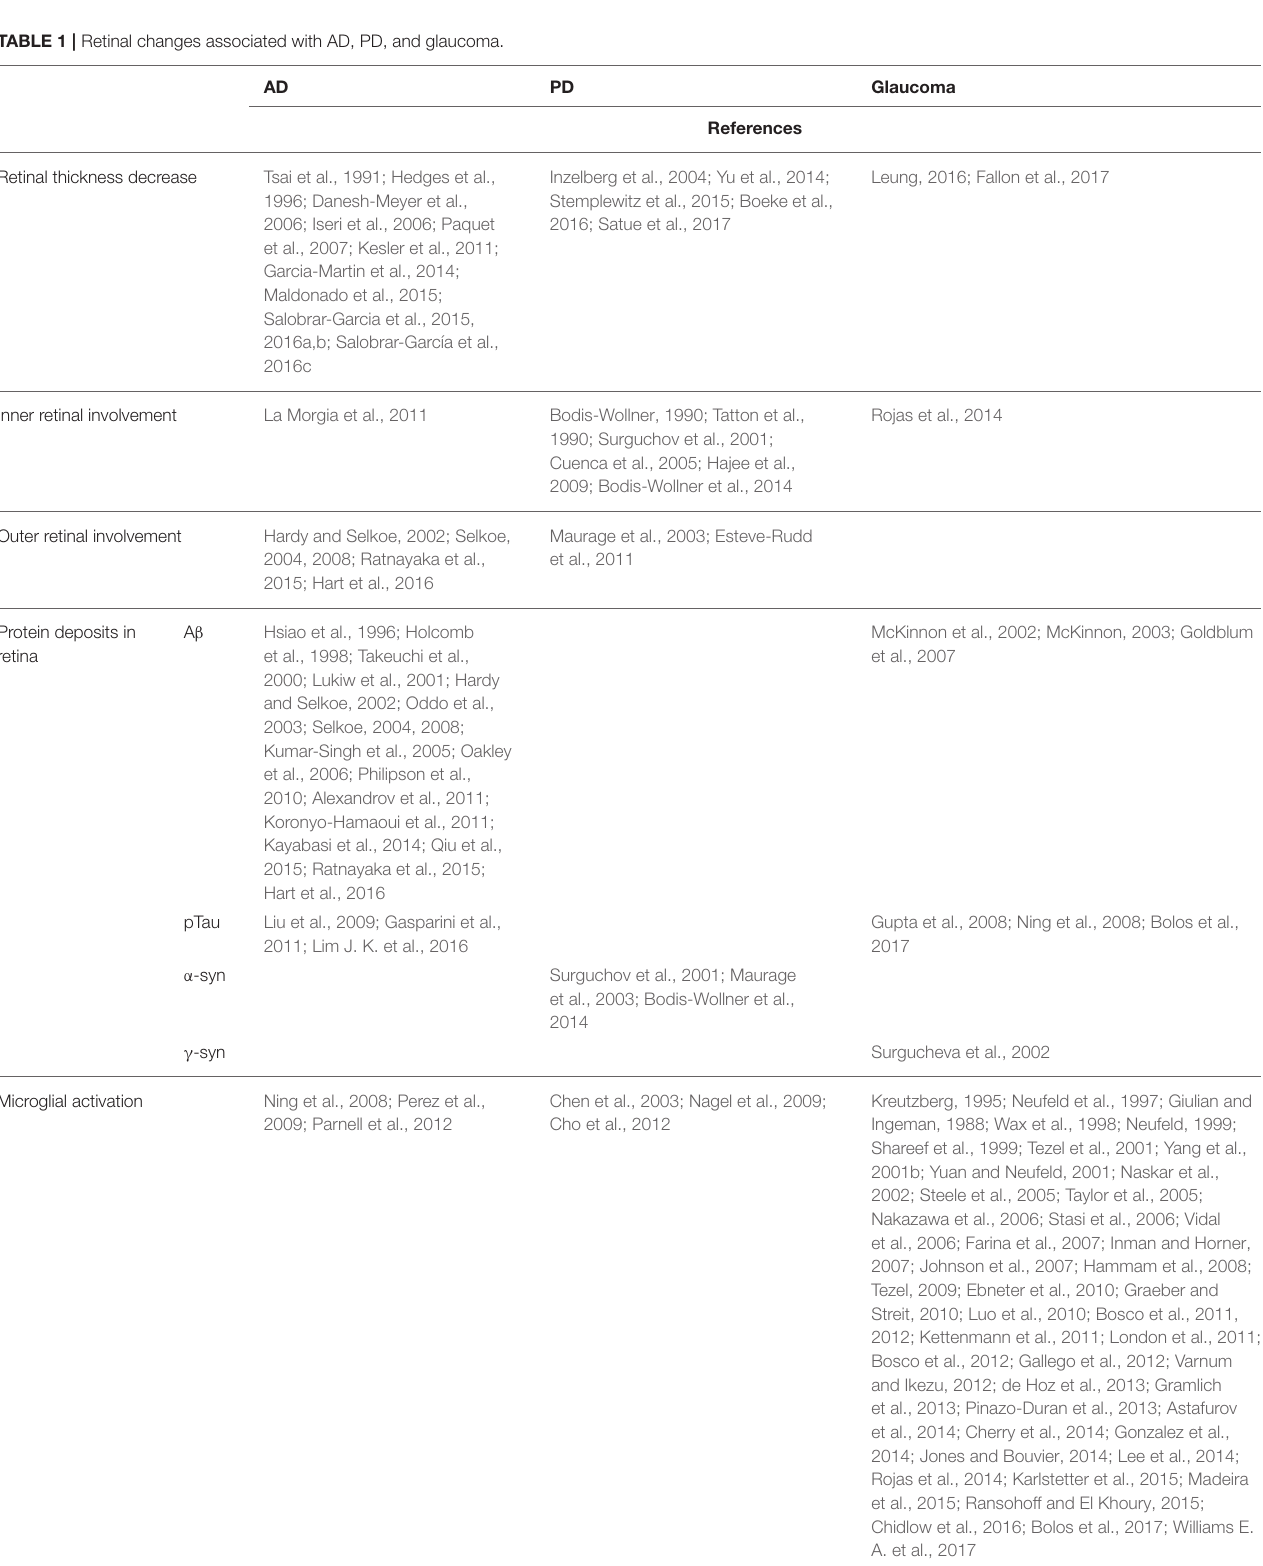
TABLE 1 | Retinal changes associated with AD, PD, and